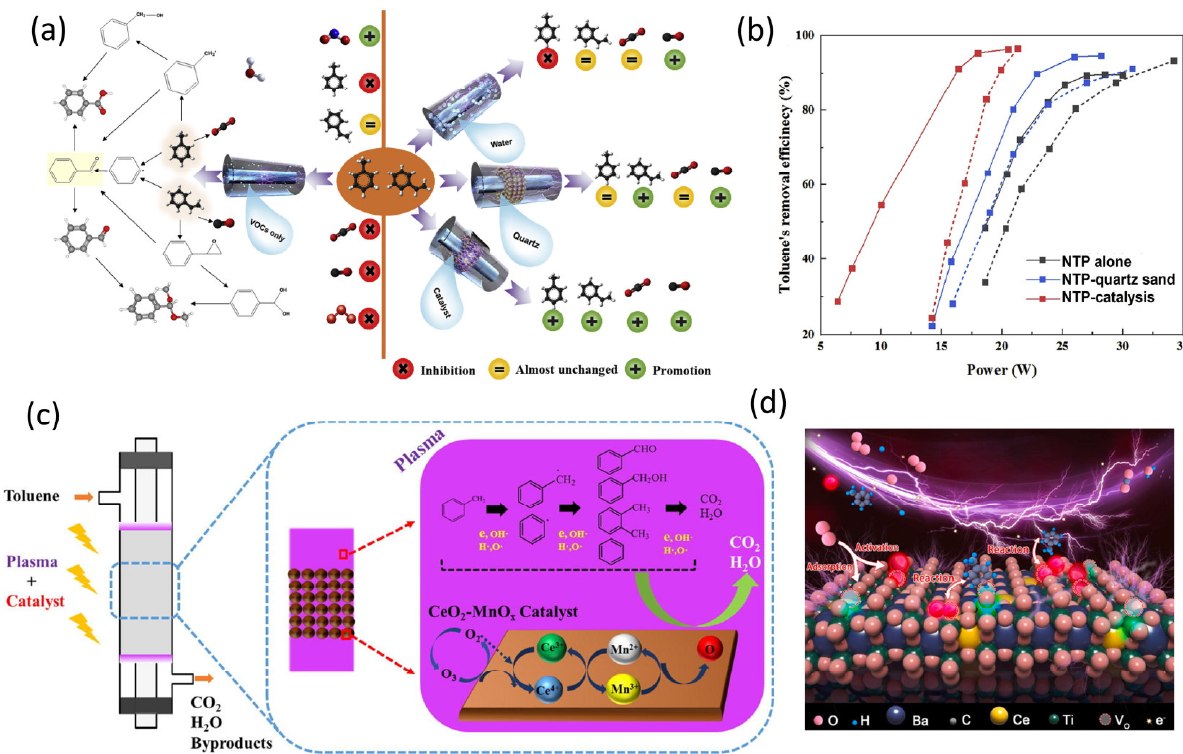
Figure 11. ( a ) Summary of suggested degradation pathways and NTP system effect on the simul- taneous removal of binary VOCs mixture. ( b ) Comparison of quartz sand and catalyst filling on VOCs’ removal efficiency of toluene. Reaction conditions: toluene (styrene): 50 ppm, air as carrier gas, and GHSV of 60,000 mL·(g·h) −1 . Reused with permission from [213]. Copyright 2021, Elsevier. ( c ) Plausi- ble reaction pathway for the plasma-catalytic Ttoluene abatement. Reused with permission from [214]. Copyright 2016, Elsevier. ( d ) Schematic diagram of the plasma-catalytic decomposition of tol- uene. Reprinted with permission from Ref. [218]. Copyright 2021, Elsevier.